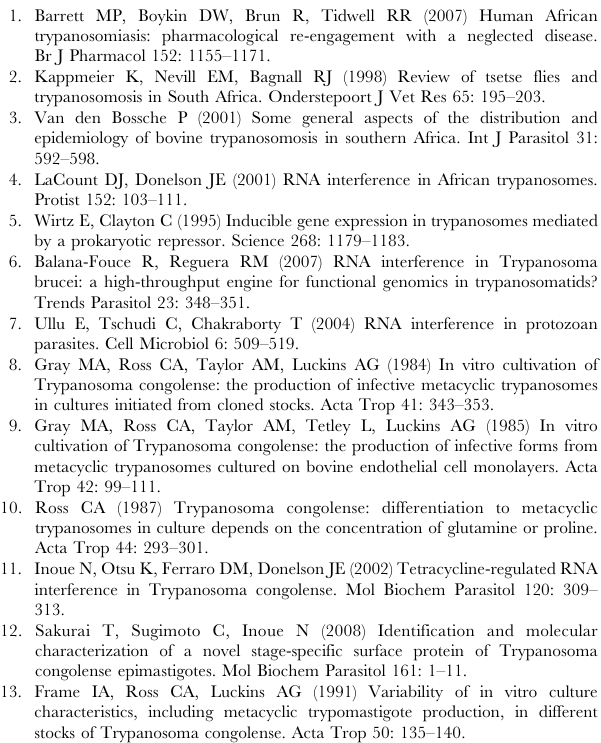
Table S2 T. brucei and T. congolense growth rates in different media. Presence ( + ) or absence ( 2 ) of BAE feeder cell layer. Normal, corresponds to routinely used medium for each species in vitro culture. RBC, medium was supplemented with red blood cell lysate as previously described. HB, medium was supplemented with haemoglobin (100 mg/ml). red, reducing agents of the medium (2-mercaptoethanol, bathocuproin and cystein) were